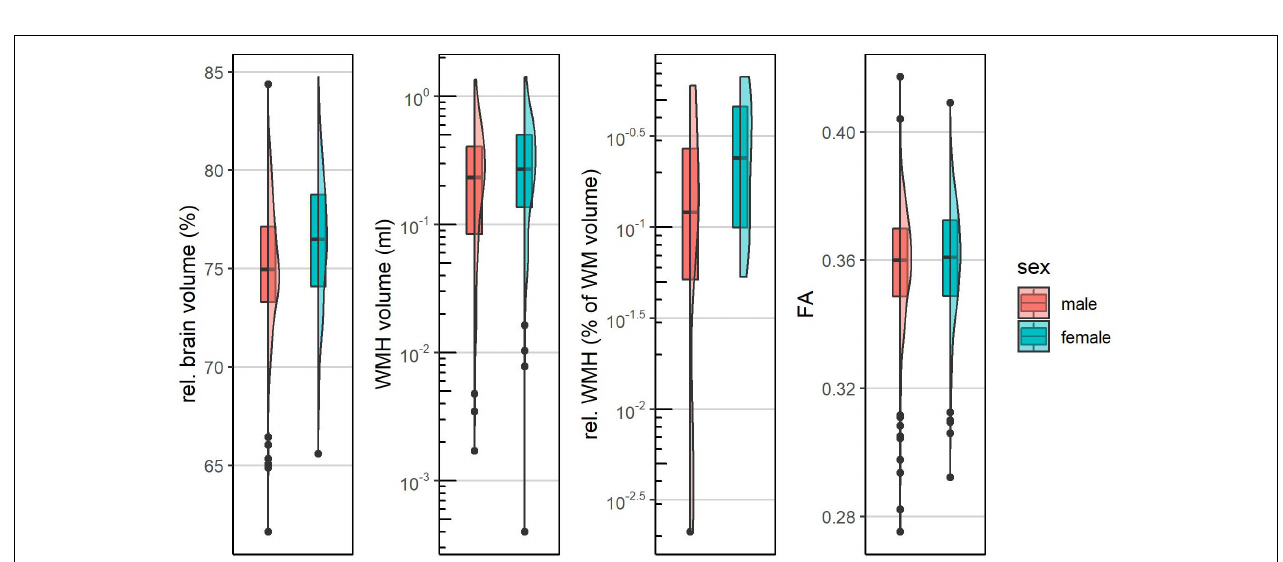
FIGURE 1 | Flow chart.